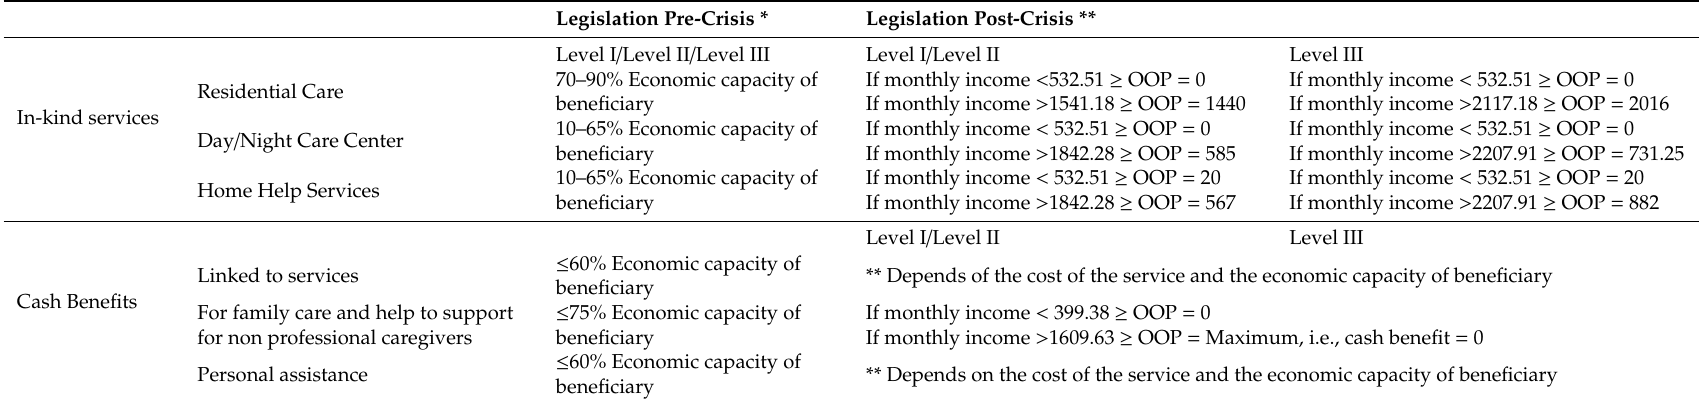
Table 1. Increased in out-of-pocket payment associated with long-term care (LTC) in